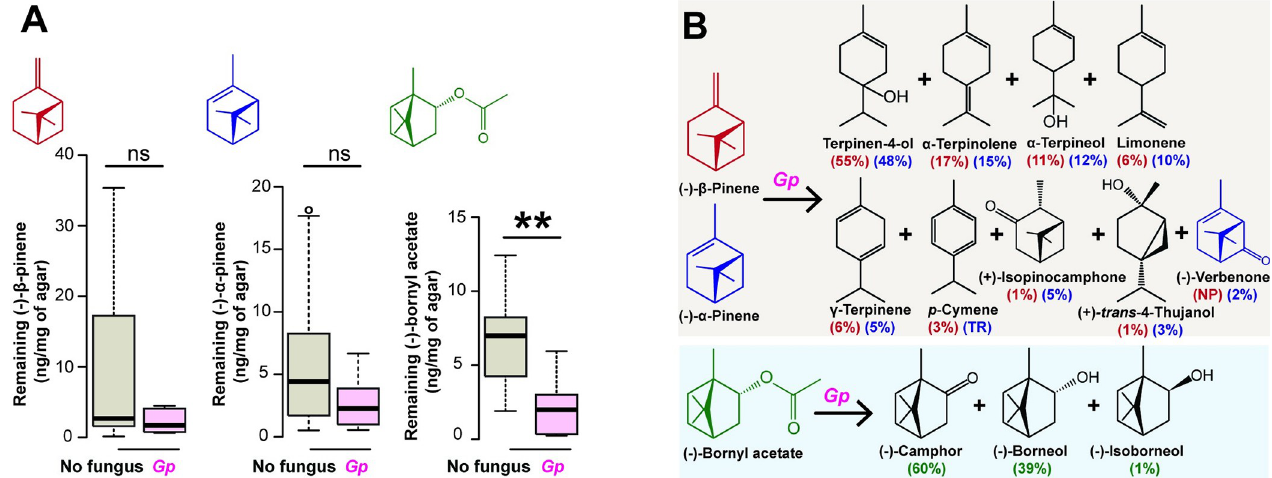
Fig 3. Metabolism of major spruce monoterpenes by a symbiotic fungus produces a variety of oxygenated monoterpenes. (A, B) Metabolism of major spruce monoterpenes by G . penicillata after fungal-infected vs. uninfected PDA was supplemented with 0.5 mg/g of ( − )- β -pinene, ( − )- α -pinene, and ( − )-bornyl acetate. (A) The amounts of starting monoterpenes remaining after 4 days. Error bars represent SEM ( n = 5 to 13). Asterisks indicate a significant difference between the PDA-inoculated G . penicillata and the fungus-free control (Welch’s t test) with ns = not significant, �� P < 0.01. (B) The most abundant metabolites of administered monoterpenes are depicted with their percentages relative to the total amounts of metabolites detected for each compound (derived from ( − )- β -pinene in red; derived from ( − )- α -pinene in purple; derived from ( − )-bornyl acetate in green). Amounts were determined by headspace collection of volatiles from the agar ( n = 3). The data underlying this Figure can be found at